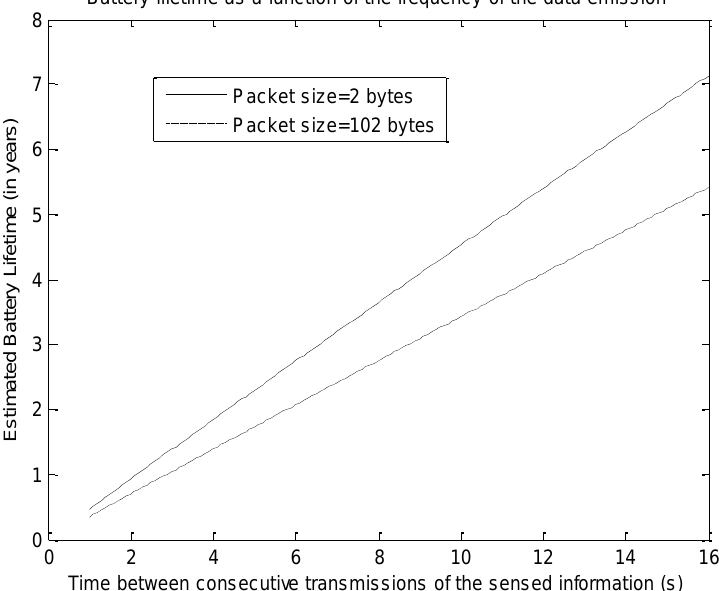
Figure 7. Expected Battery lifetime (in optimal conditions) of a mote as a function of the frequency of data emission for two different sizes of sensed data (battery capacity is assumed to be 1,200